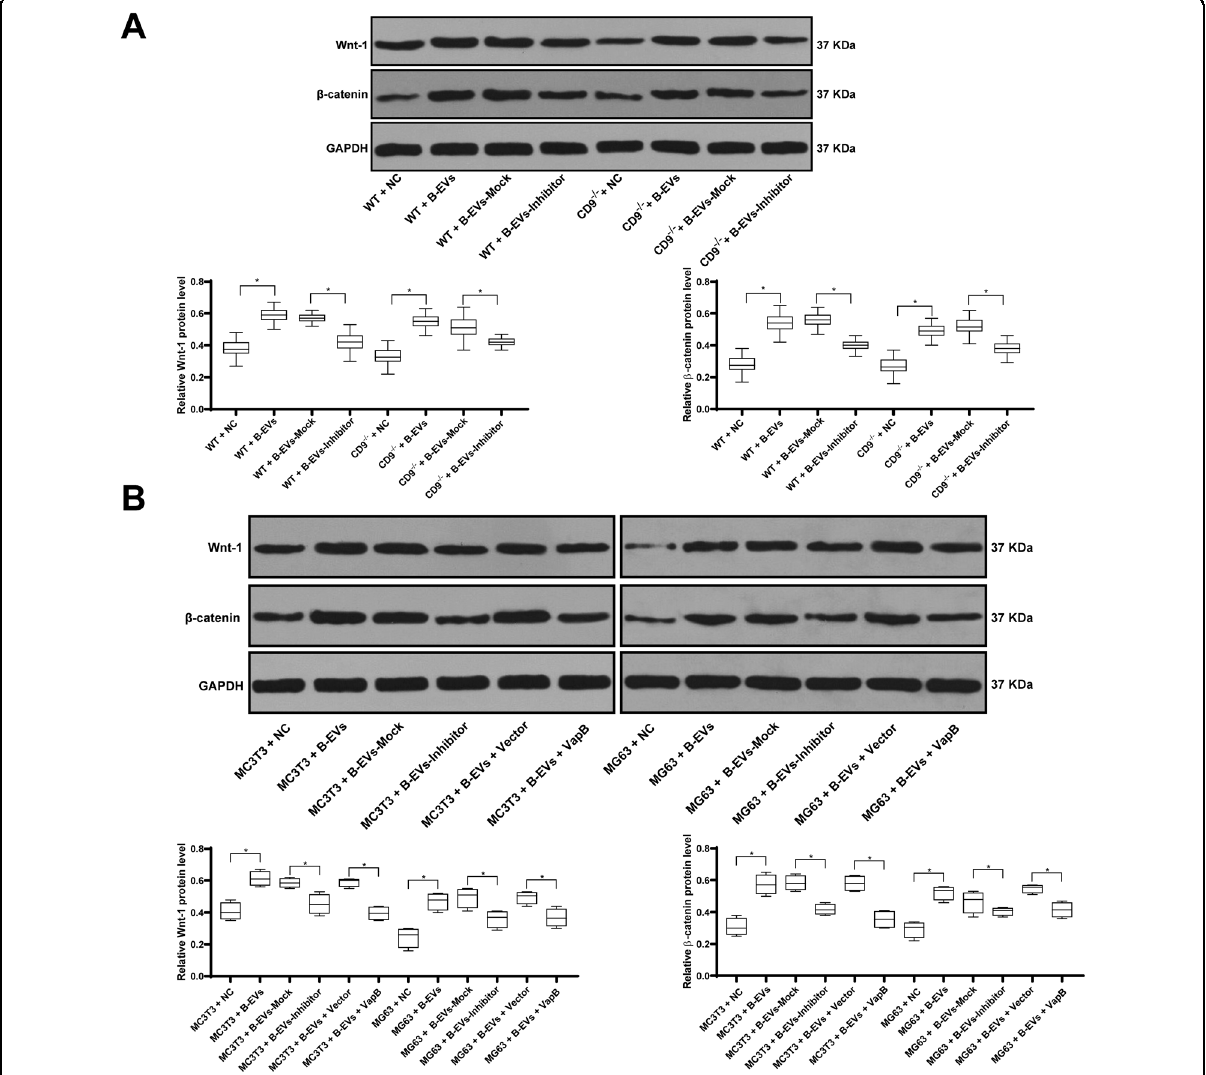
Fig. 8 B-EVs-carried miR-335 targets VapB and promotes bone fracture recovery by activating the Wnt/ β -catenin pathway. WT or CD9 − / −